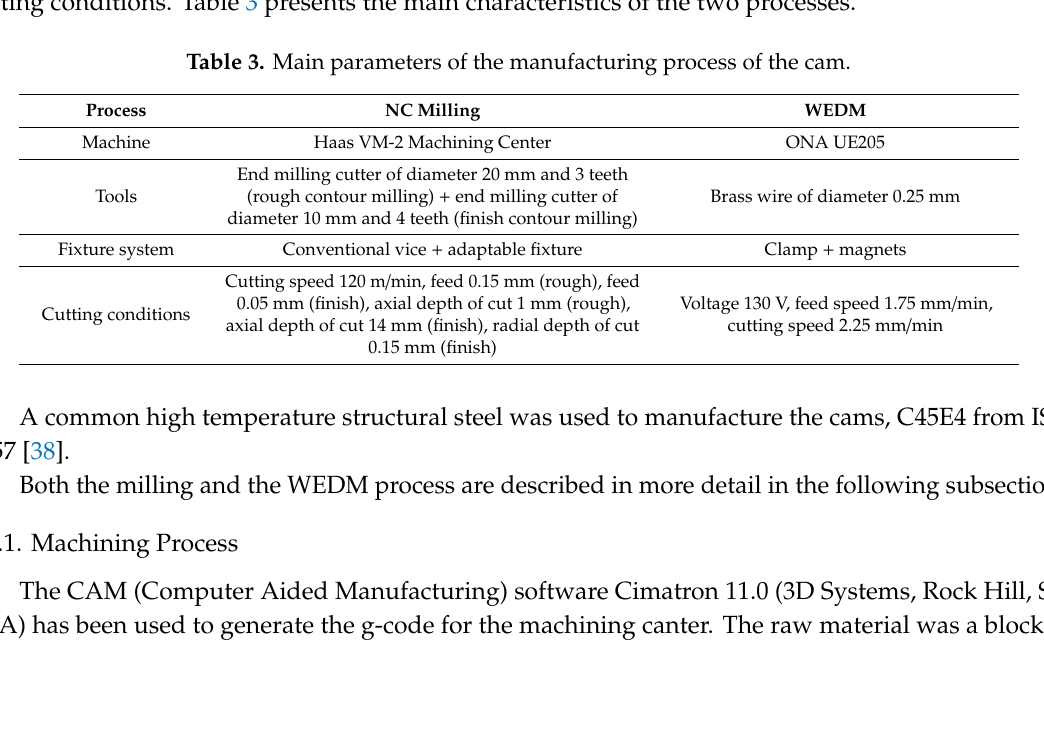
Table 3. Main parameters of the manufacturing process of the